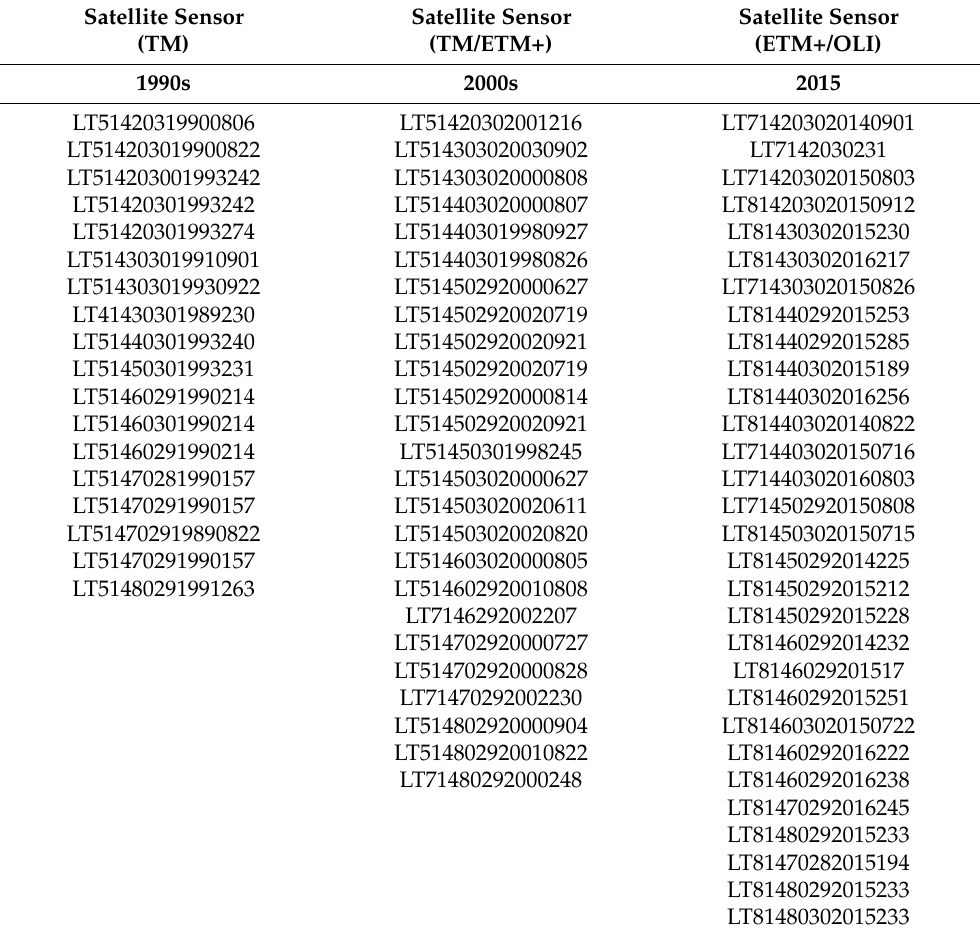
Table 2. Remote sensing image data of Landsat